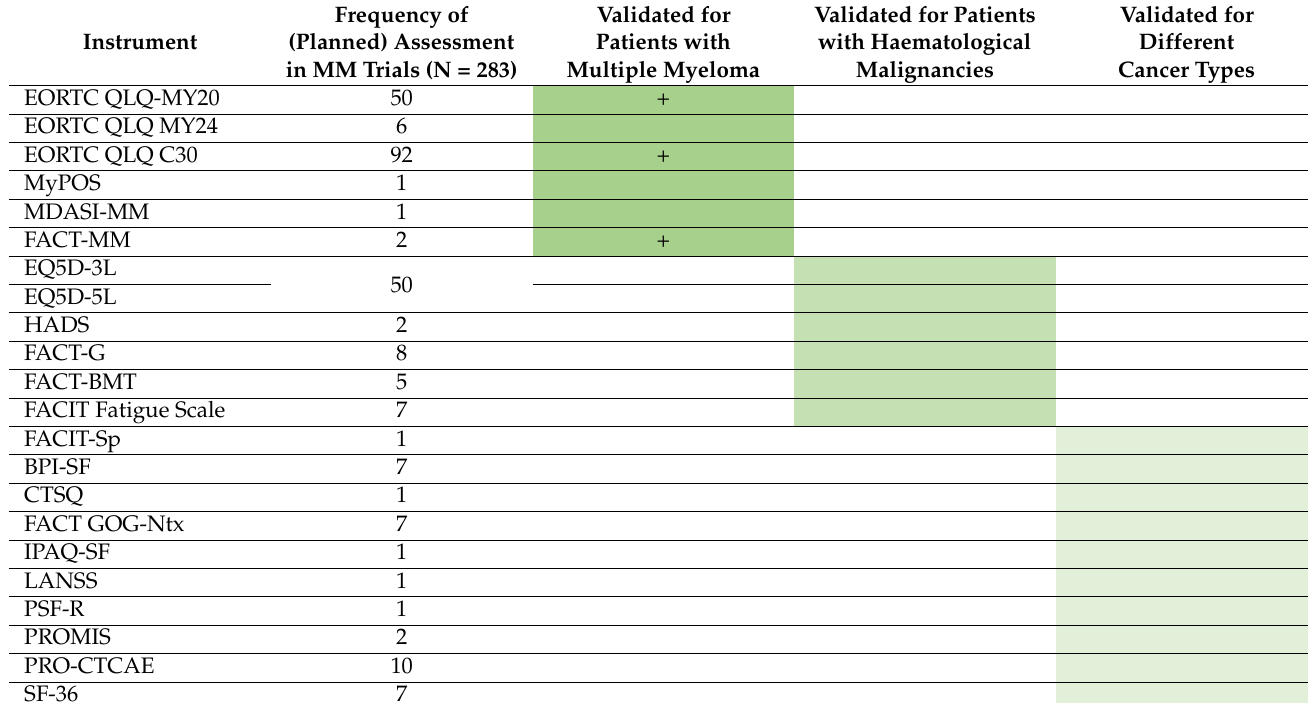
Table 1. Overview of PRO instruments and validated populations.